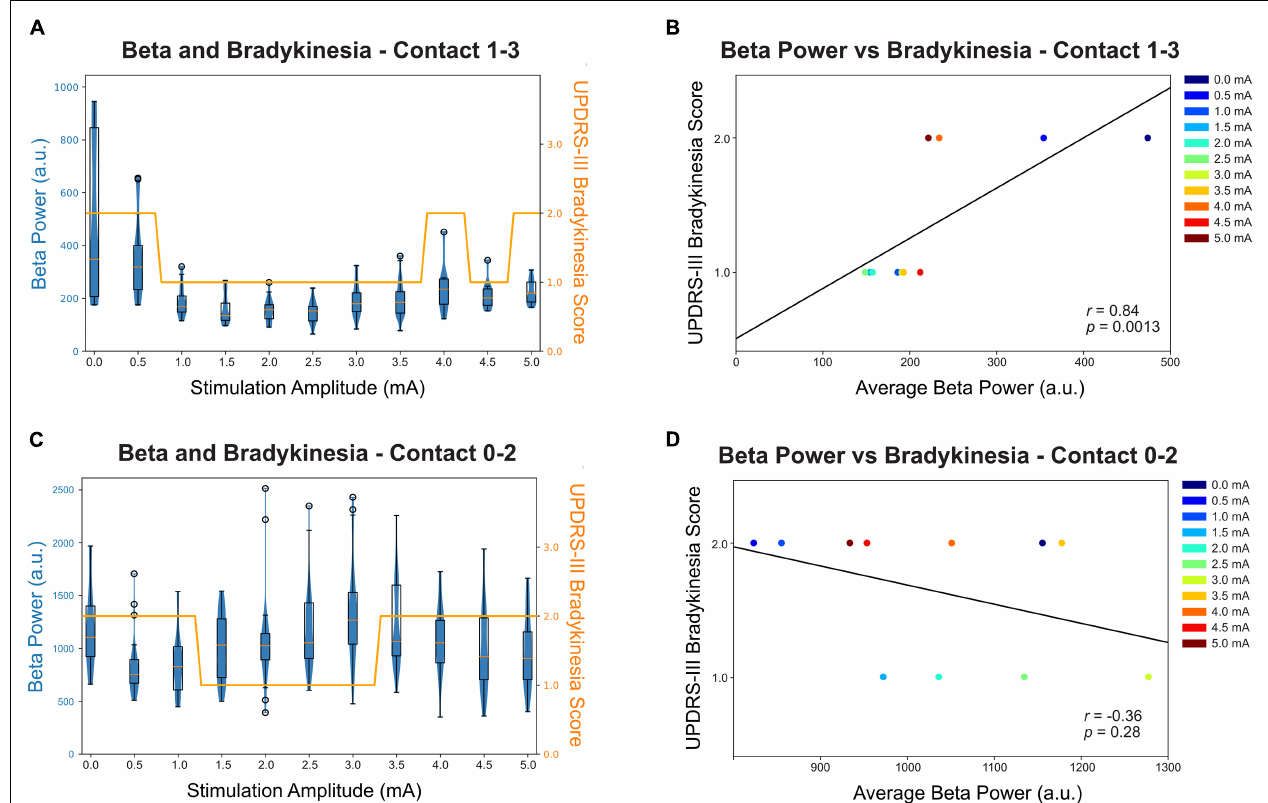
FIGURE 3 | Relationship between beta power (recorded from contact 1–3 when stimulating at contact 2) and bradykinesia score (UPDRS Part 3 subitem 23). (A) The beta peak power (23.44 Hz) for contact 1–3 was averaged over each stimulation amplitude and shown in a box-violin plot with whisker at 150% of the interquartile distance and outliers were marked as circles. Each datapoint indicates a 500 ms power value collected by Medtronic Percept neurostimulator at the specified frequency band. The bradykinesia scores were plotted in the same scale for comparison. (B) The correlation between average beta power and bradykinesia score at each stimulation amplitude for contact 1–3. The beta power was statistically significantly correlated with bradykinesia scores, with increased beta power correlated with worse bradykinesia ( p = 0.0013). (C) The beta peak power (17.57 Hz) for contact 0–2 was averaged over each stimulation amplitude and shown in a box-violin plot with whisker at 150% of the interquartile distance and outliers were marked as circle. (D) The correlation between average beta power and bradykinesia score at each stimulation amplitude for contact